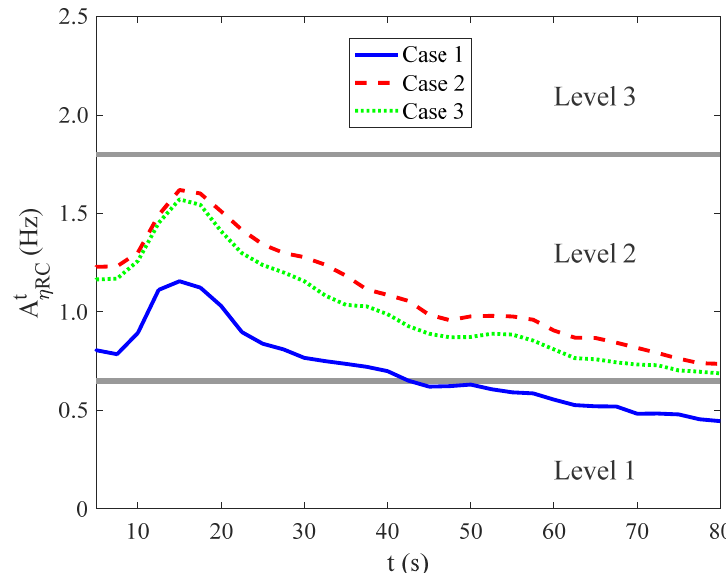
Figure 18. Time-varying combined attack activity rates with SAS on.